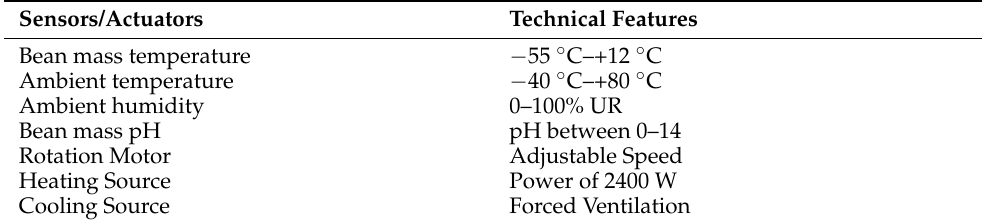
Table 3. Sensors and actuators technical features (Hardware